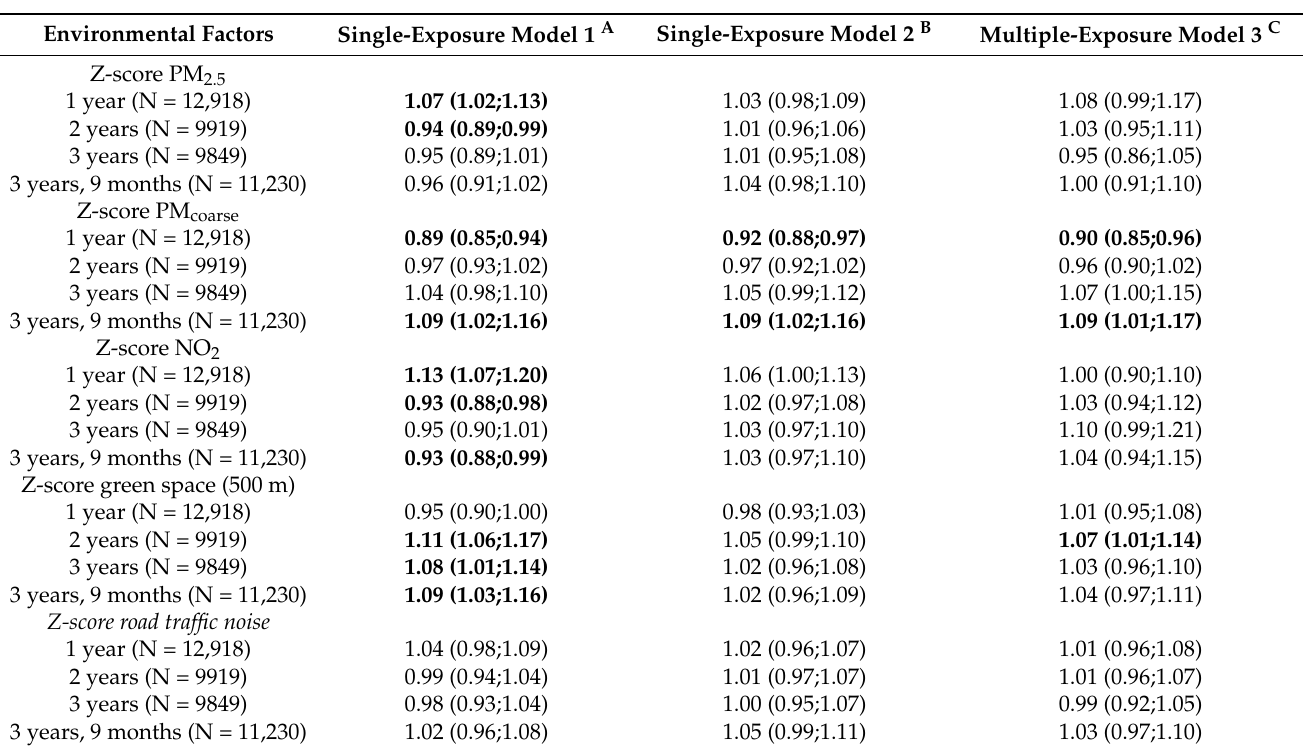
Table 3. Association between global developmental score and environmental factors, stratified per age group. Values are Odds Ratios (95% confidence interval), expressing the odds of a positive developmental score (medium/high, DAZ ≥ − 1) for a one unit change in the z-score of exposures. N represents the number of children (visits) included in the